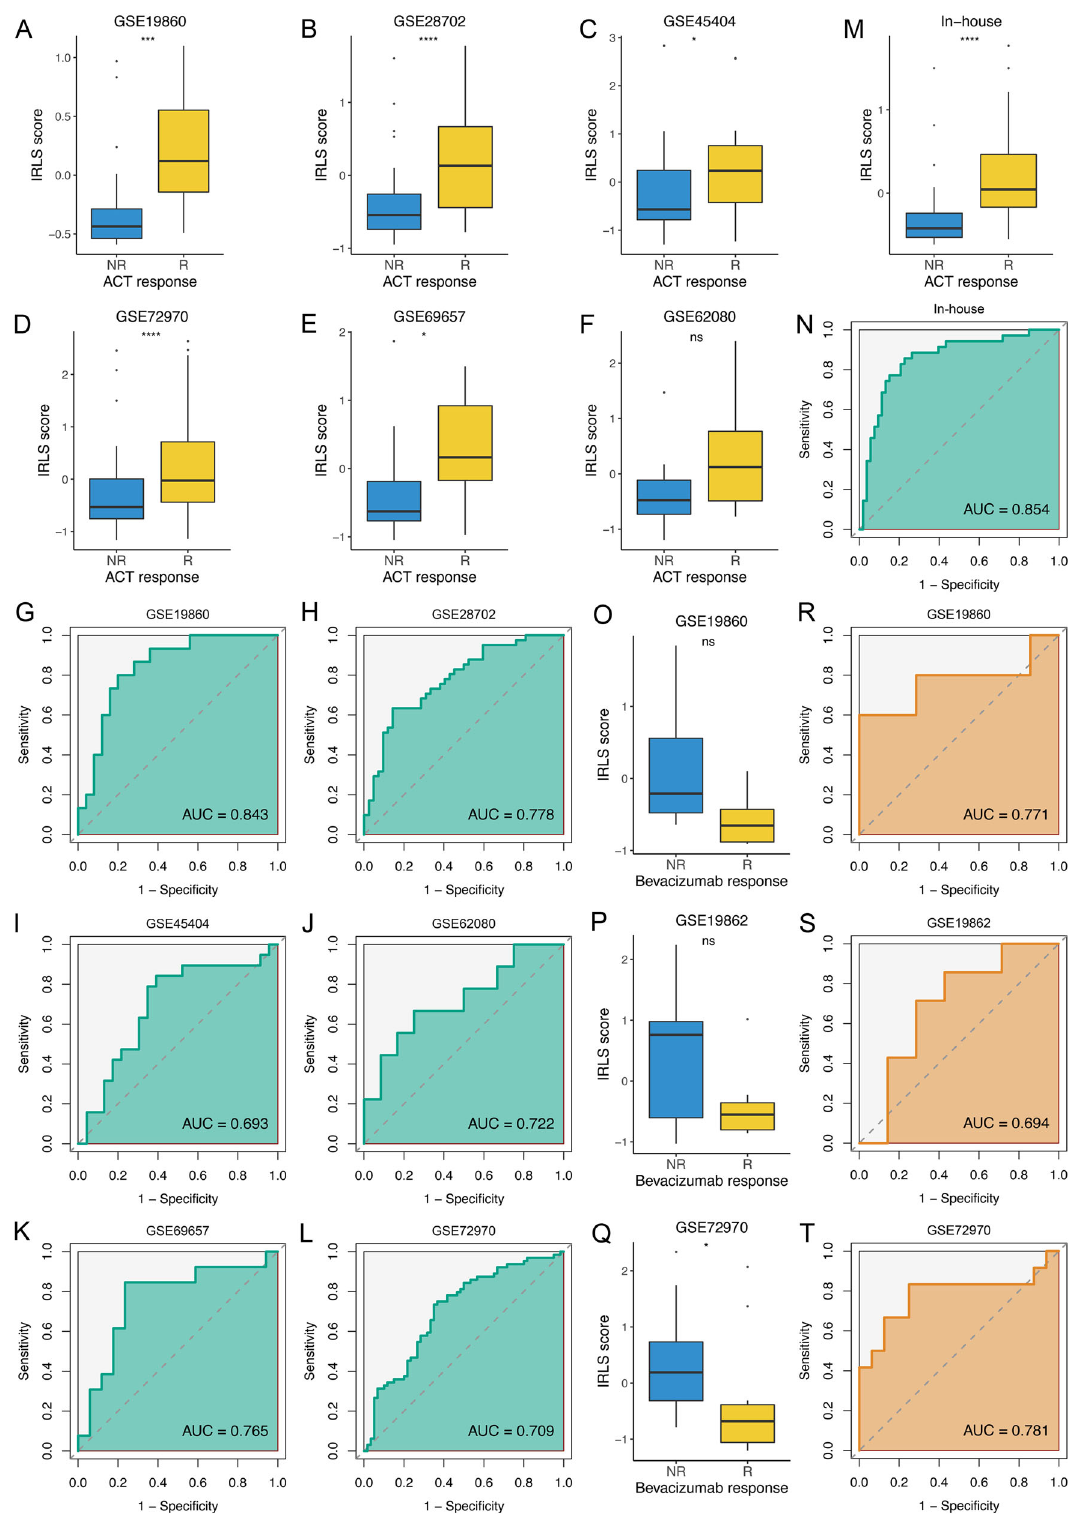
Fig. 8C), and in-house cohorts ( r = − 0.548, Fig. 7H). This